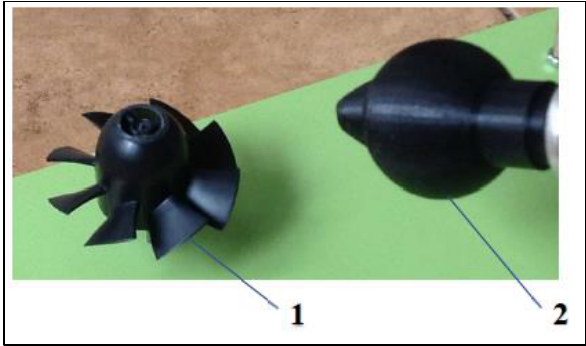
Figure 33. The main elements of the experimental system are in a static state: 1- impeller; 2- nozzle. In Figure 34, arrows schematically show the working fluid flow Q 0 and the pumped medium flow Q 1 . In this case, air flows are shown.